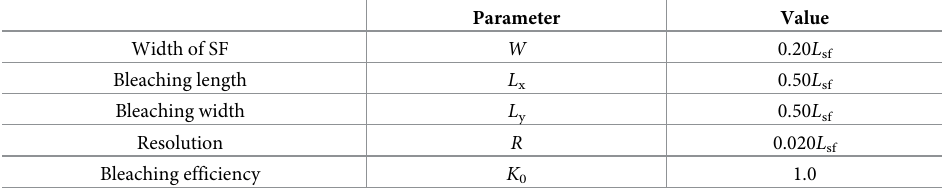
Table 1. Parameters used for the numerical analysis in Fig